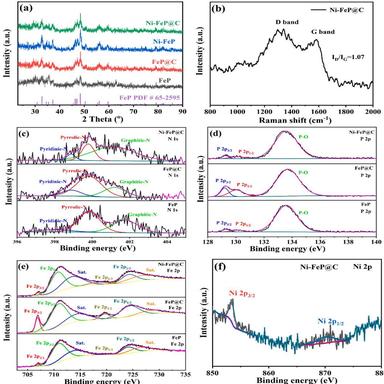
XRD patterns of FeP, FeP@C, Ni-FeP and Ni-FeP@C (a); Raman spectra of Ni-FeP@C (b); XPS spectra of the FeP, FeP@C and Ni-FeP@C hybrid: N 1s (c); P 2p (d); Fe 2p (e); XPS spectra of the Ni-FeP@C hybrid: Ni 2p (f).